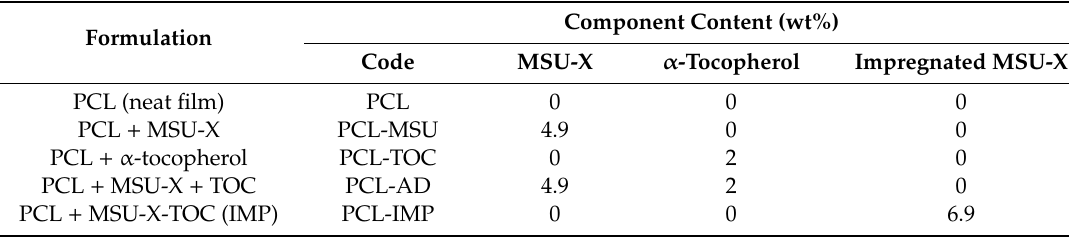
Table 1. Di ff erent formulations obtained in this work and their codification.